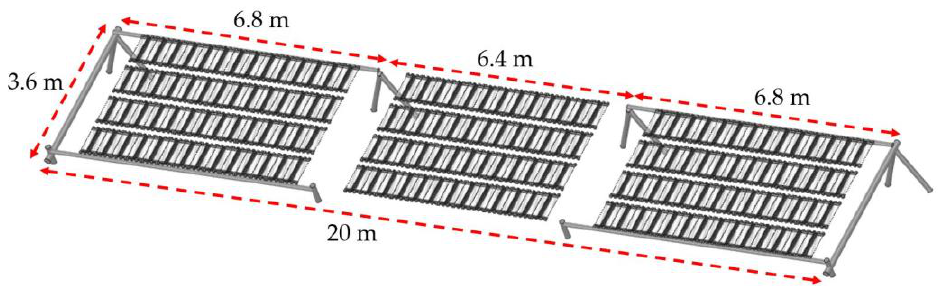
Figure 5. A modified solid model of DL for simulation.